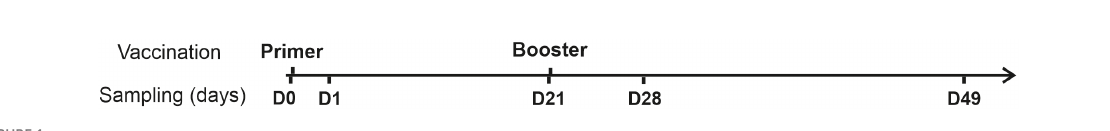
FIGURE 1 Timeline of the study. The BNT162b2 vaccine was administered on day 0 and 21. Heparin plasma samples for CCG analysis were collected on day 0 just prior to primer dose administration (D0), day 1 (D1), day 21 just prior to booster dose administration (D21), and day 28 (D28). For anti- RBD and anti-S1 serology, serum samples were collected on day 49 (D49) after the administration of the primer vaccine